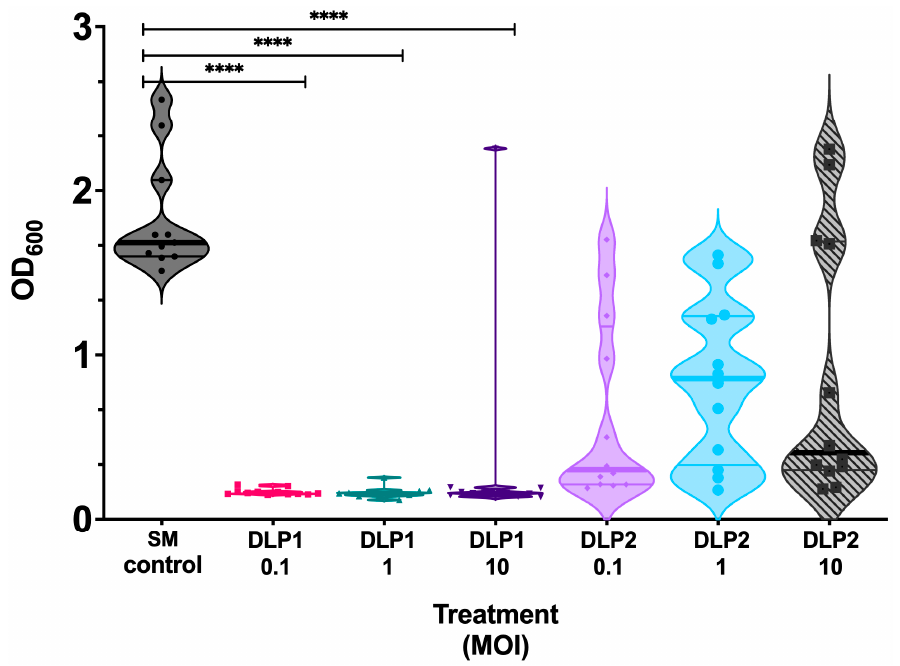
Figure 6. Biofilm inhibition of DLP1 and DLP2 at varying MOIs compared to the AB5075 cm control. Static biofilms were formed in a 96-well plate in the presence or absence of varying MOIs of DLP1 and DLP2 over 24 h and stained with 0.1% crystal violet. OD 600 was measured. The data are presented as a violin plot showing the median and quartiles of a biological triplicate and technical quadruplicate experiment. Statistical significance is represented as ****, p < 0.0001.